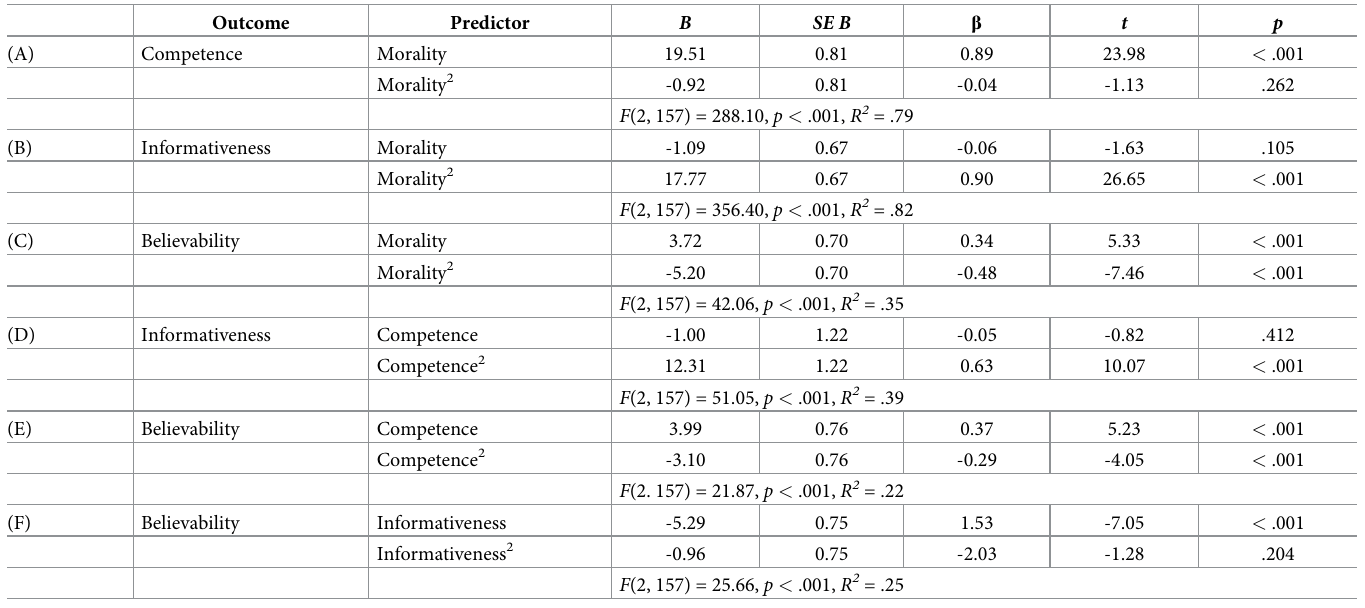
Table 2. Orthogonal polynomial regression (linear and quadratic) results for morality, competence, informativeness, and believability